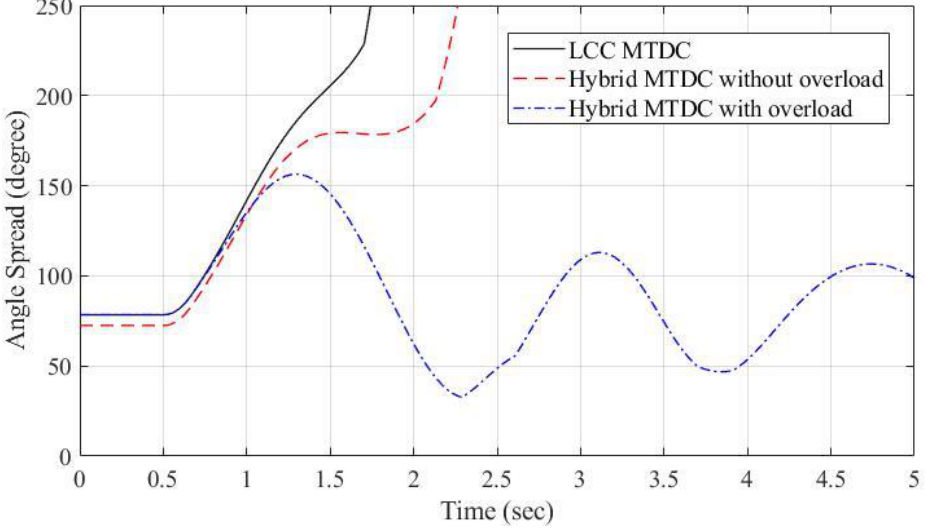
Figure 20. The angle spread from the simple overload simulation for each topology.